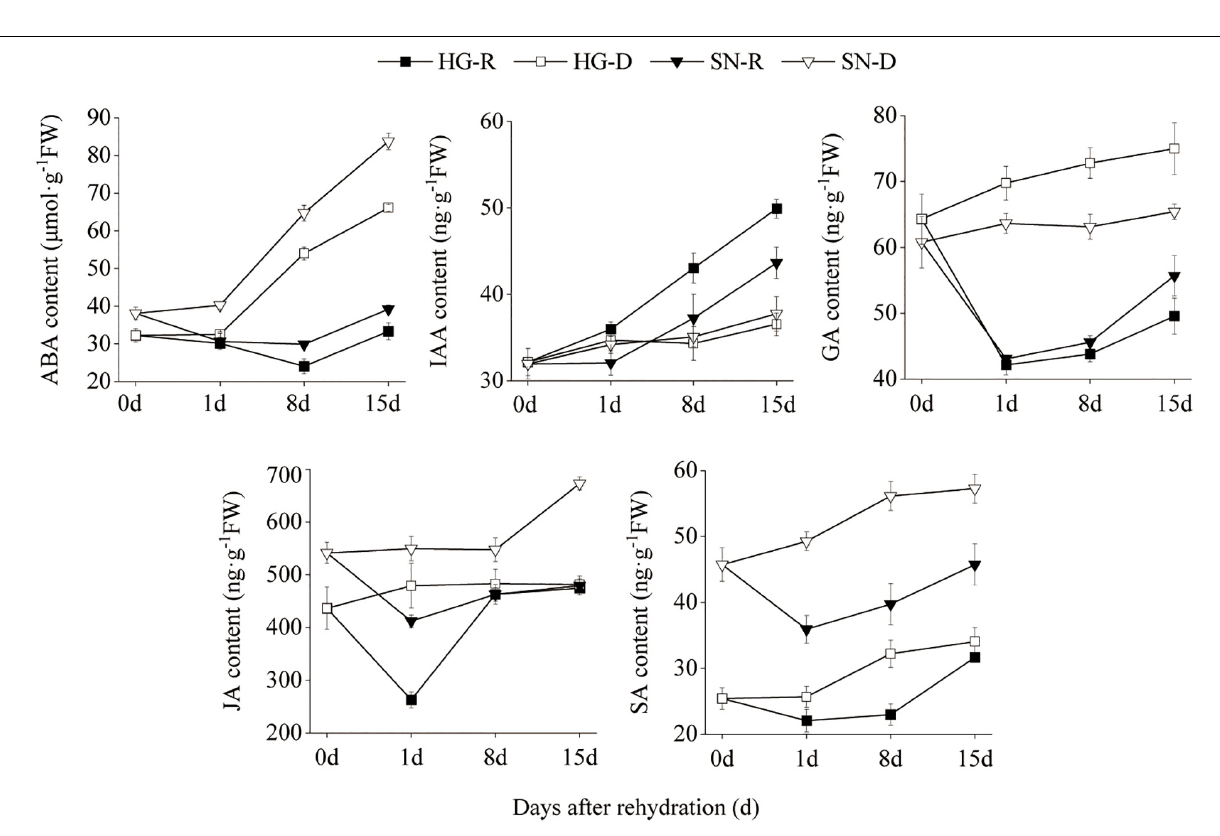
Frontiers in Plant Science |